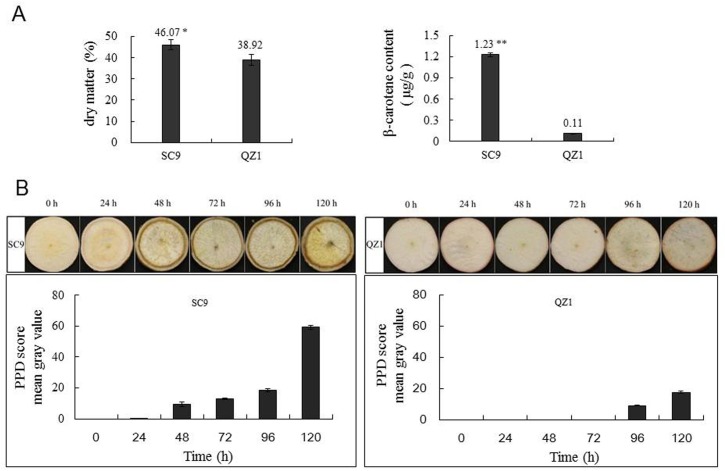
(A) The analysis of dry matter and β-carotene contents of cassava injured storage roots in both genotypes SC9 and QZ1. Values are the means ± SE from three biological replicates. * and ** indicate significant differences at P < 0.05 and 0.01, respectively, by SPSS Duncan’s multiple comparison tests. (B) PPD score analysis of injured storage root in SC9 and QZ1 genotypes after postharvest. Visual examination of SC9 and QZ1 storage root slices at the time-points from 0h to 120h. PPD scores at different time-points were obtained using ImageJ image processing software based on the mean gray values percentages of vascular discoloration. The mean gray value at 0h was set to 0.